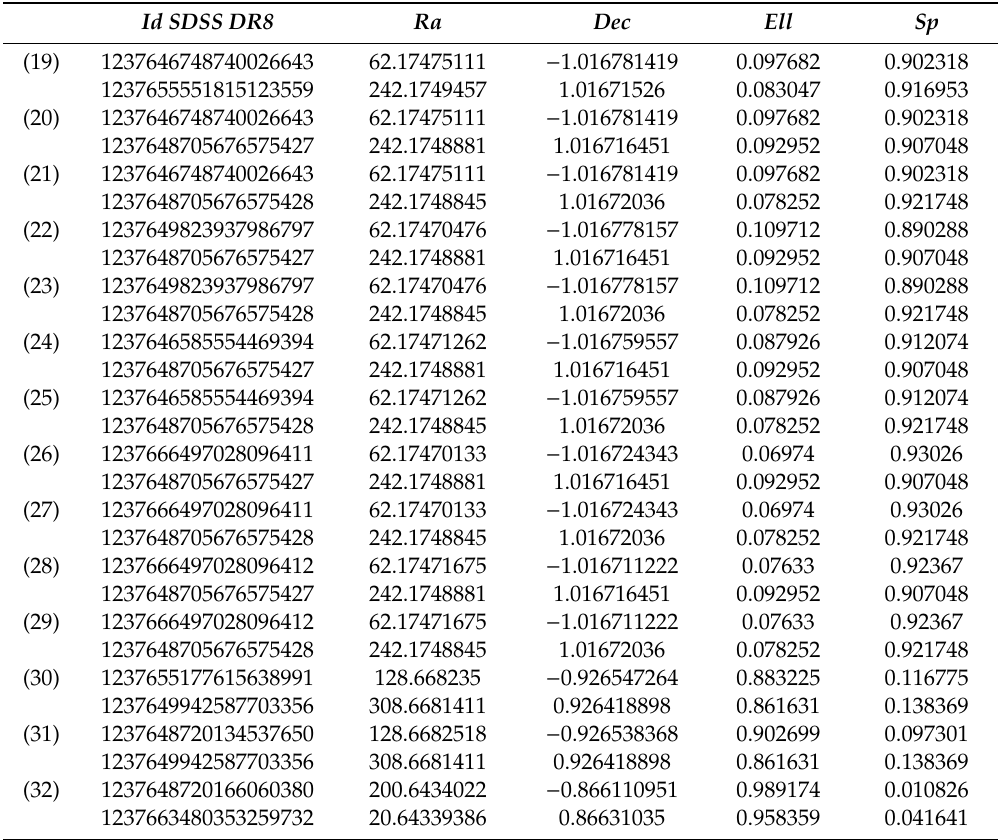
Table A5. Pairs of galaxies for the e ff ect of cosmic mirror from catalog [41]. Id SDSS